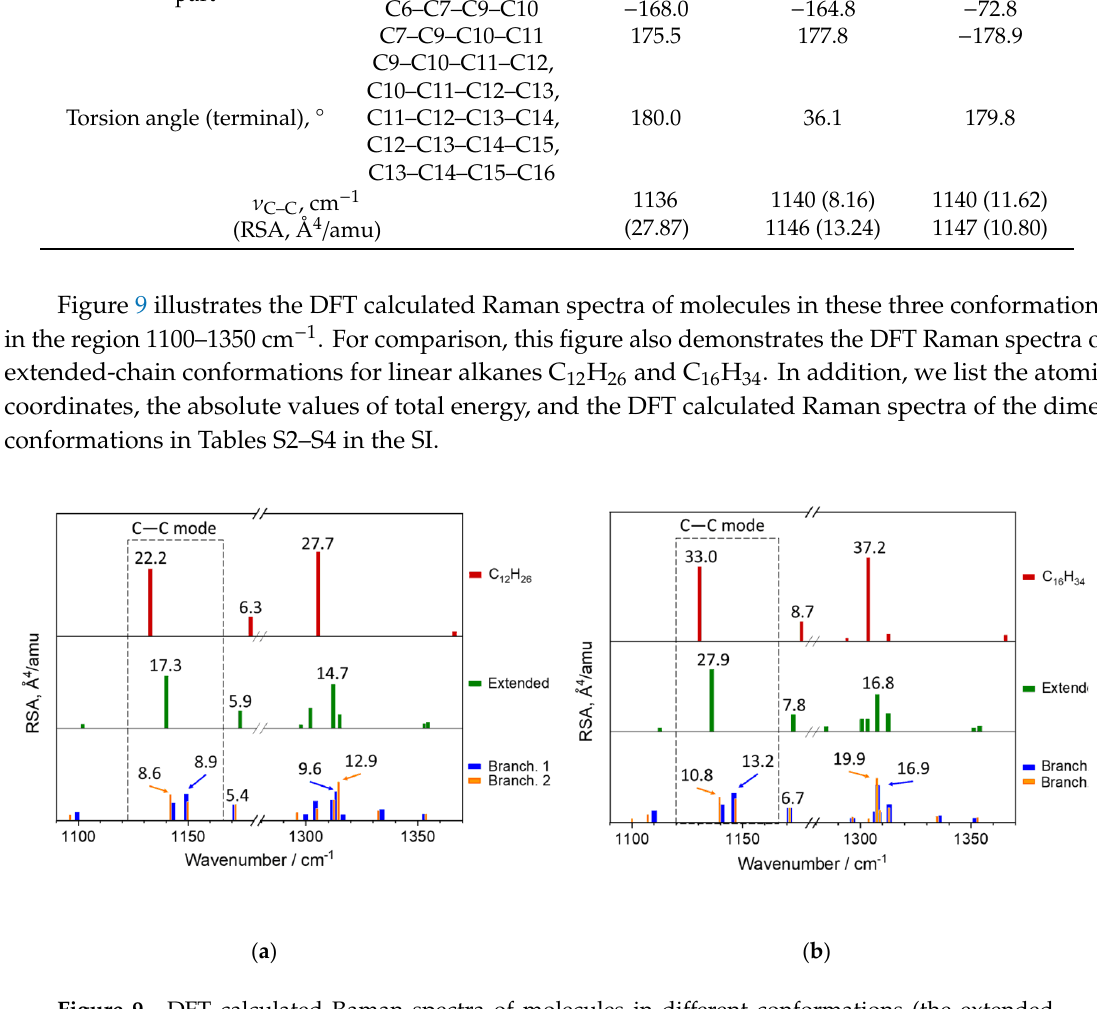
Figure 8. Density functional theory (DFT) calculated conformations of dimers of 1-hexene ( a – c ) and 1-octene ( d – f ): extended-chain conformation ( a , d ), branched 1 chain conformation ( b , e ), branched 2 chain conformation ( c , f ).